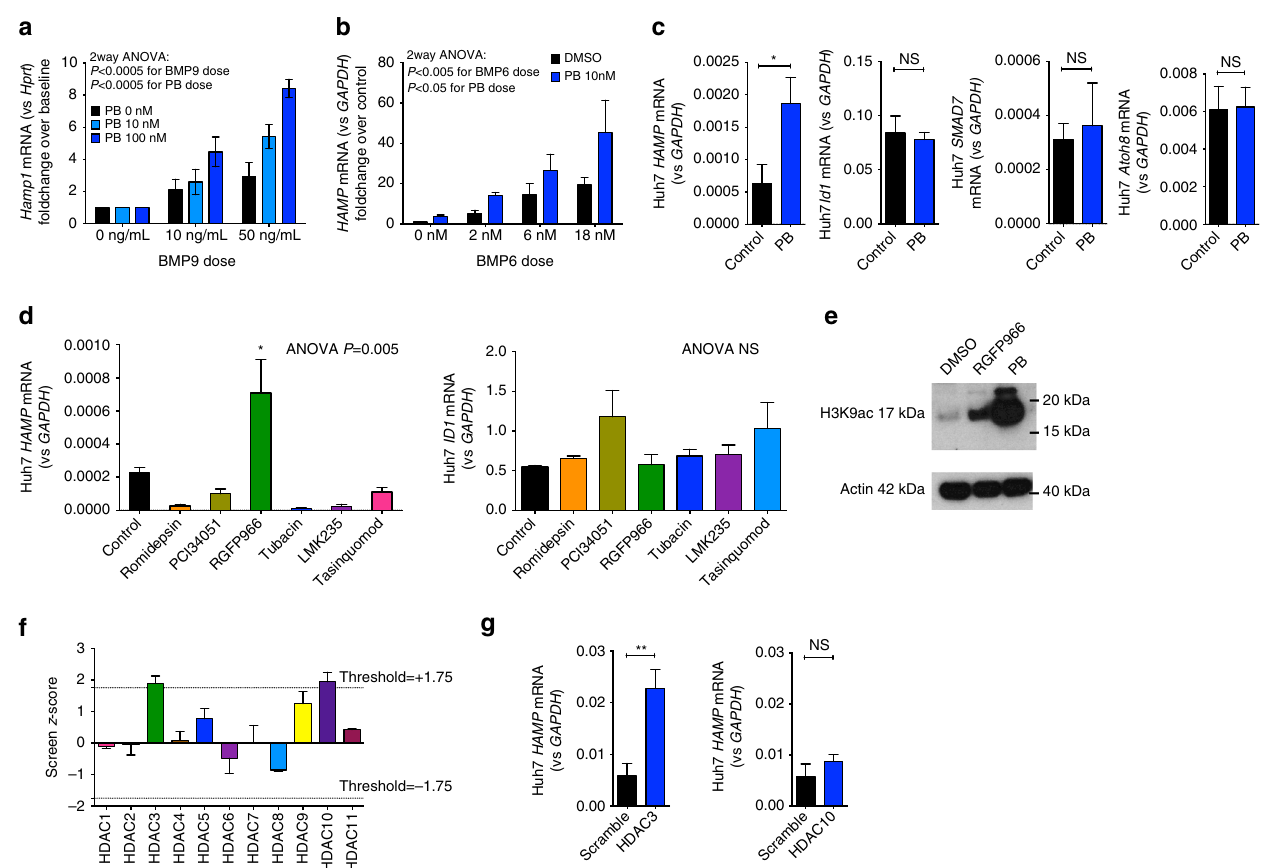
Fig. 6 In vitro effects of PB on HAMP expression in liver-derived cells. a Effect of Panobinostat 10 and 100 nM on BMP9- (0, 10, and 50 ng/ml) induced Hamp1 expression (relative to Hprt ) in mouse precision cut liver slices. Data are normalized to baseline (untreated cells). N = 3 separate experiments. Two-way ANOVA by BMP9 dose and PB treatment. b Effect of Panobinostat 10 nM and BMP6 (0, 6, and 18 nM) on HAMP expression (relative to GAPDH ) in HuH7 human hepatoma cells. Data are normalized to baseline for each condition. N = 3 separate experiments. Two-way ANOVA by BMP6 dose and PB treatment. c Effects of PB treatment vs DMSO on HAMP , ID1 , SMAD7 , and ATOH8 mRNA expression in Huh7 cells, n = 3 separate experiments (same experiment as BMP6 0 nM condition from b . d Effect on HAMP and ID1 mRNA of treatment with isoform-speci fi c HDAC inhibitors in Huh7 cells. HDAC(s) targeted by each inhibitor presented in the text. N = 3 separate experiments. One-way ANOVA, t -test for comparison between RGFP966 and control. e Whole-cell H3K9ac in Huh7 cells treated with RGFP966 and PB. f Depiction of HAMP promoter luciferase activity from knockdown of each HDAC isoform in a previously published RNAi screen (two replicates per HDAC). g Validation of HDAC3 and HDAC10 knockdown effects on HAMP mRNA expression in Huh7 cells ( n = 3 separate experiments, paired t -test). Data are means ± s.e.m. * P ≤ 0.05; ** P ≤